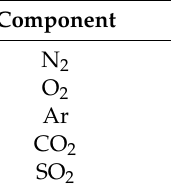
Table A4. Dry air composition.